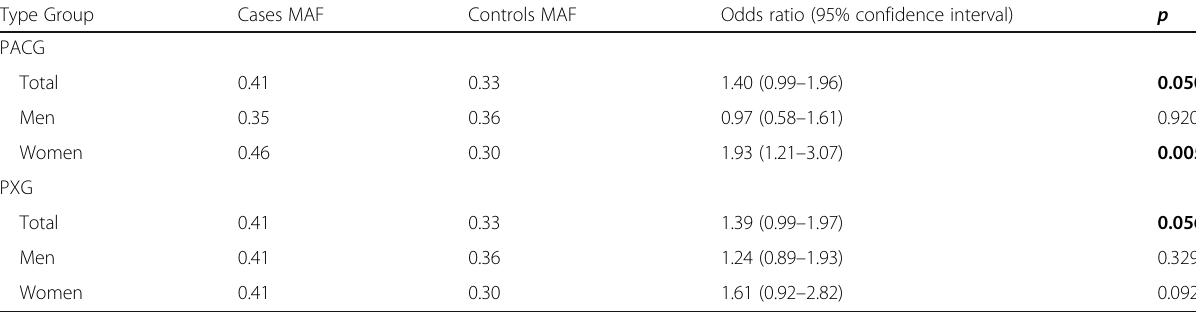
Table 1 Minor allele frequency of rs12997[G] polymorphism in cases and controls Type Group